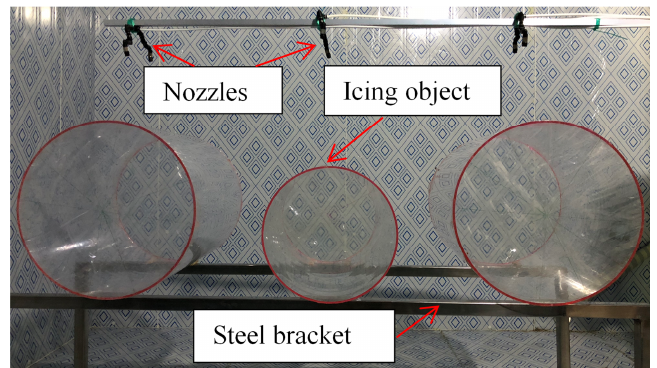
Figure 2. Experiment setup.